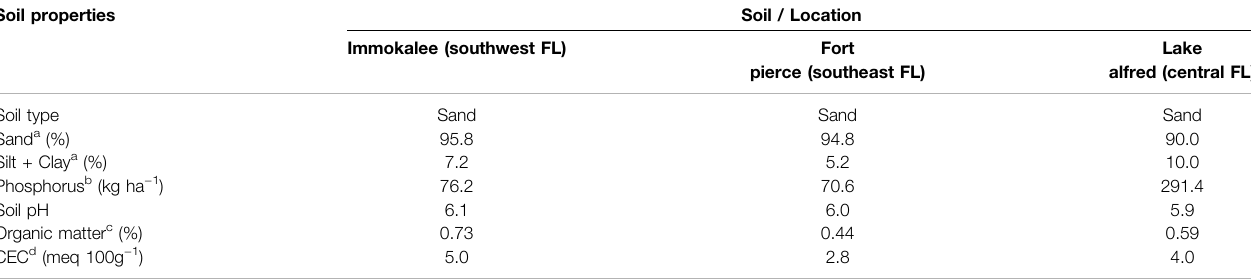
TABLE 1 | Selected physical and chemical properties of the citrus production soils (top 15 cm) used in this study. Soil